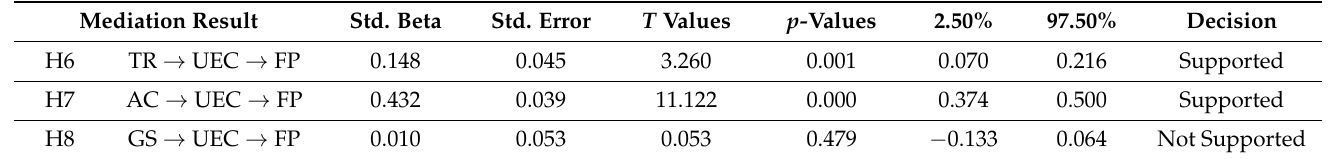
Table 6. Mediation